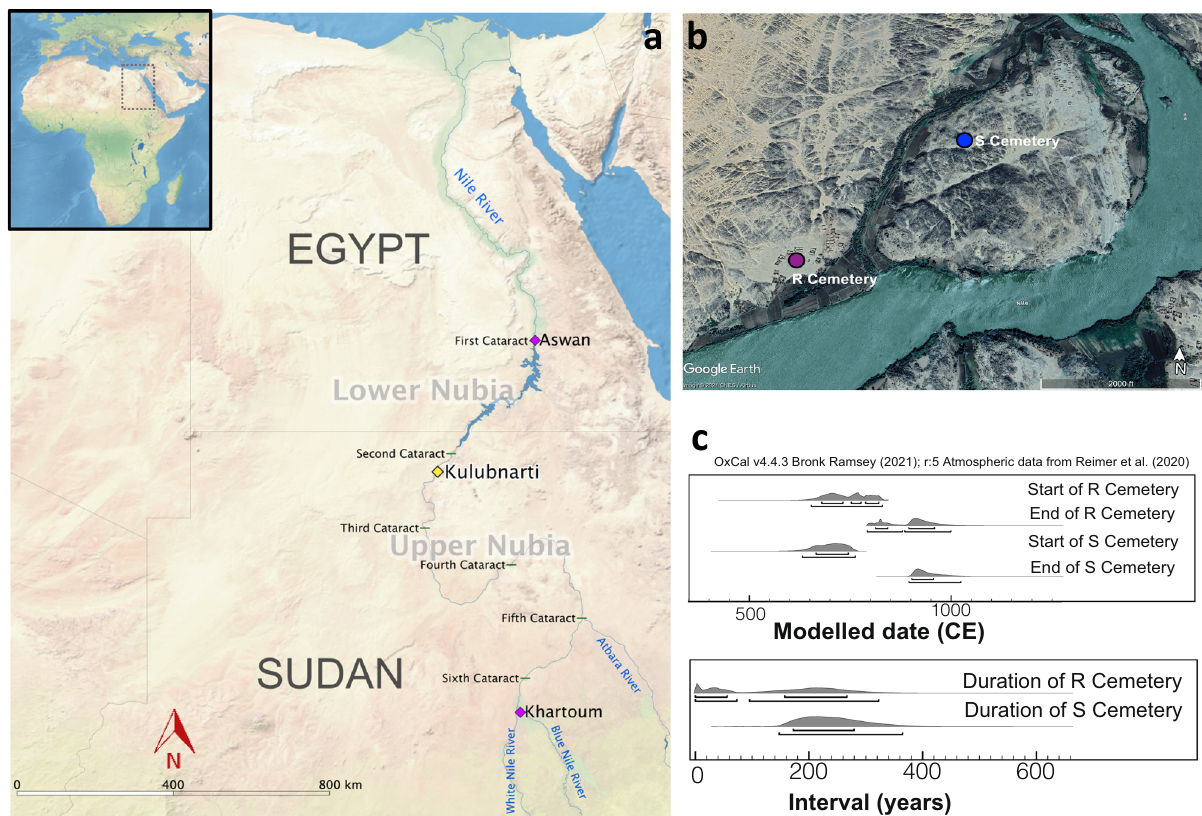
Fig. 1 Geographic and temporal context of Kulubnarti. a Map of Nubia, including location of Kulubnarti (yellow diamond), present-day cities of Aswan and Khartoum (magenta diamonds), and the six numbered cataracts of the Nile River (green lines). Inset map shows the location of focus within Africa. b Zoomed view of Kulubnarti showing the location of sites 21-S-46 ( ‘ S cemetery ’ ) and 21-R-2 ( ‘ R cemetery ’ ) marked with yellow diamonds. Maps made with QGIS Geographic Information System v.3.6.0 and Google Earth Pro; basemaps from Natural Earth (naturalearthdata.com) ( a ) and Google Earth ( b ). c Modeled start and end dates (top) and duration of use (bottom) of R and S cemeteries based on 29 newly generated radiocarbon ( 14 C) dates shows their contemporaneity. Brackets indicate the 68.3% highest posterior density (hpd) and 95.4% hpd ranges, the former of which are referred to in the text (Supplementary Note 2; individual 14 C data provided in Supplementary Table 1 and modeled in Supplementary Fig.